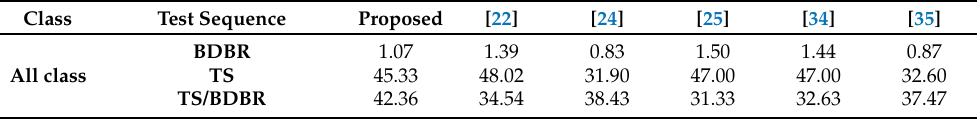
Table 8. Encoding performance of the proposed method compared with the anchor method and previous